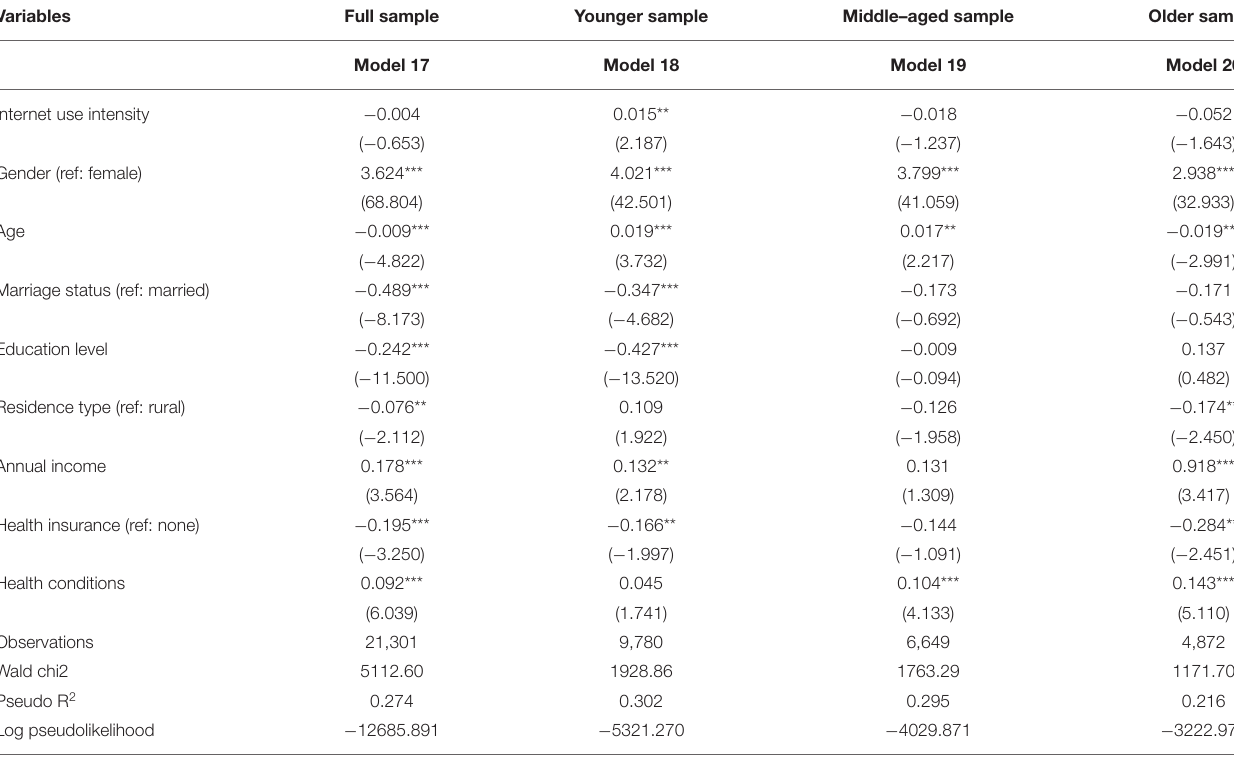
TABLE 7 | Results of the relationship between internet use intensity and smoking & drinking ( N =